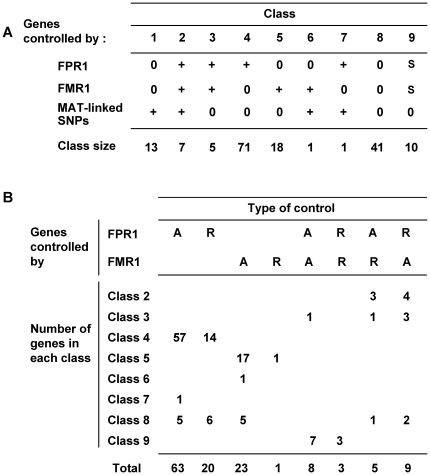
Partitioning of mat+ vs mat− differentially transcribed genes.
A: Partitioning of differentially transcribed genes into classes controlled by mating-type genes or mating-type linked SNPs. Genes with FC≥2 or FC≤−2 (P<0.005) in mat+ vs fpr1−, mat− vs fmr1− and fpr1− vs fmr1− comparisons are considered as being controlled by FPR1, FMR1 and mating-type linked SNPs, respectively. 0: no regulation; +:induction or repression; s: similar control in mat+ and mat− strains. B: Partitioning of the mating-type target genes into groups with identical transcriptional patterns. Genes with FC≥2 in mat+ vs fpr1− and mat− vs fmr1− comparisons were considered as activated (A) by FPR1 and FMR1, respectively. Genes with FC≤−2 in mat+ vs fpr1− and mat− vs fmr1− comparisons were considered as repressed (R) by FPR1 and FMR1, respectively.